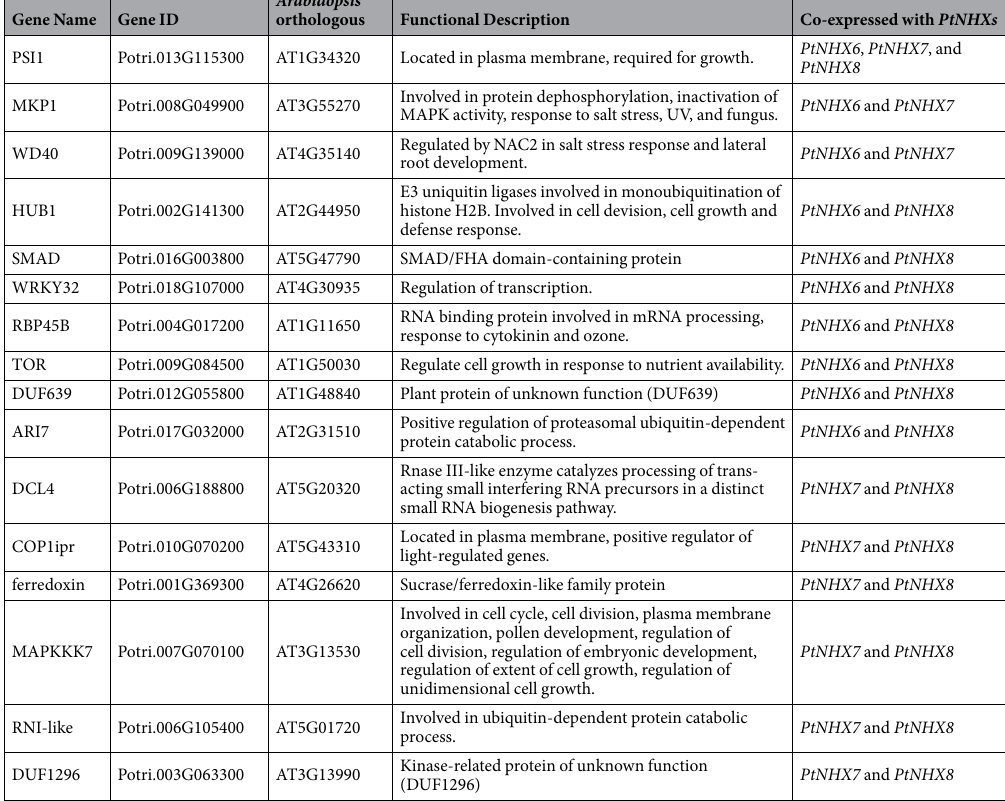
Table 4. Annotation of hub genes in the PtNHX co-expression